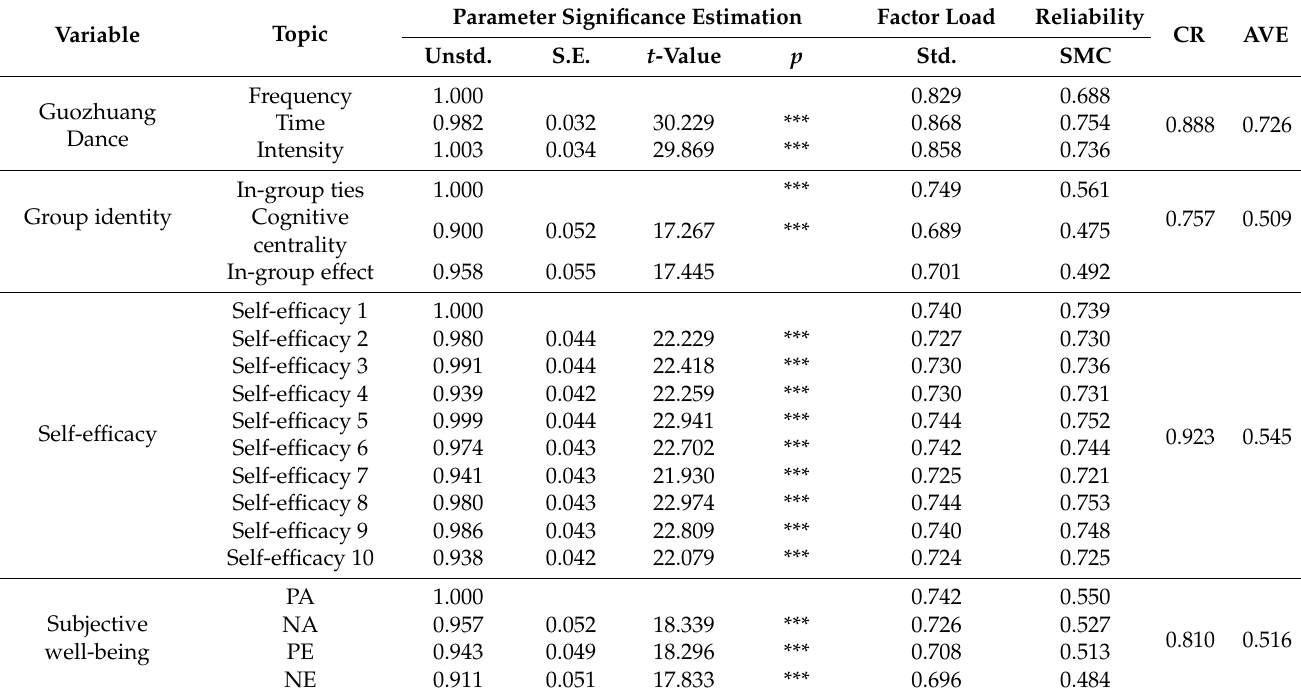
Table 2. Confirmatory factor analysis.